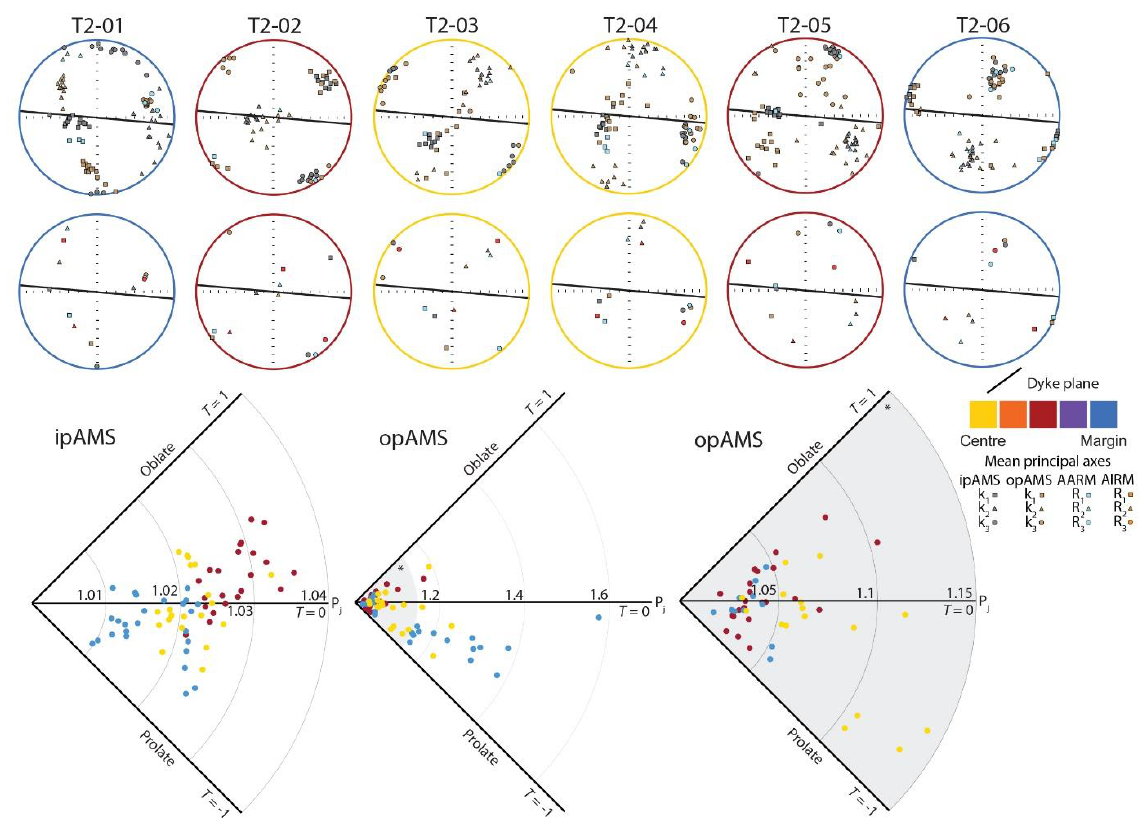
Figure A6. Comparison between different magnetic fabrics analysed on samples in traverse T2 of the Sosa dyke.